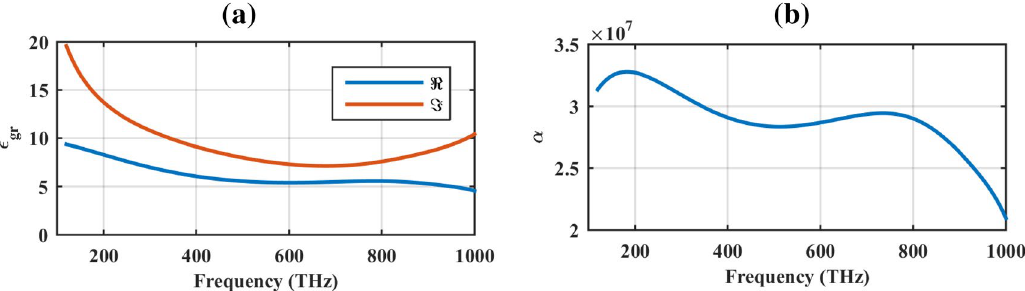
Figure 1. ( a ) Real and imaginary parts of graphene equivalent permittivity in the solar spectrum and ( b ) its attenuation